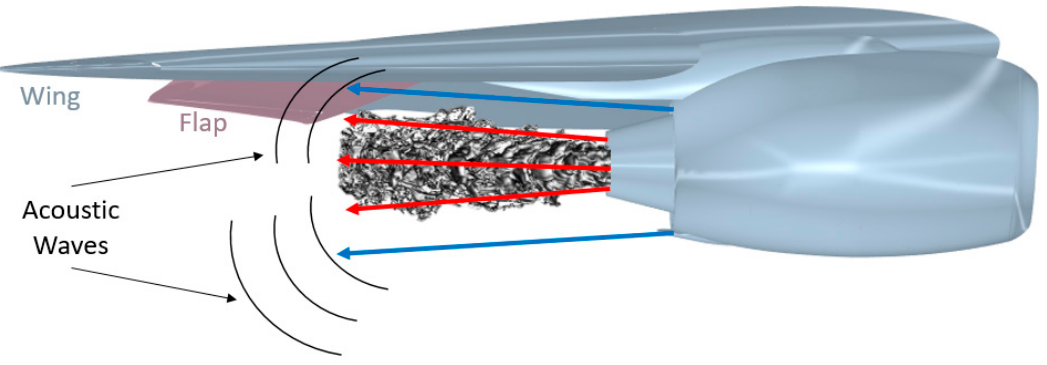
Figure 3. Schematics of jet flow and acoustic wave interactions with aerodynamic surfaces.